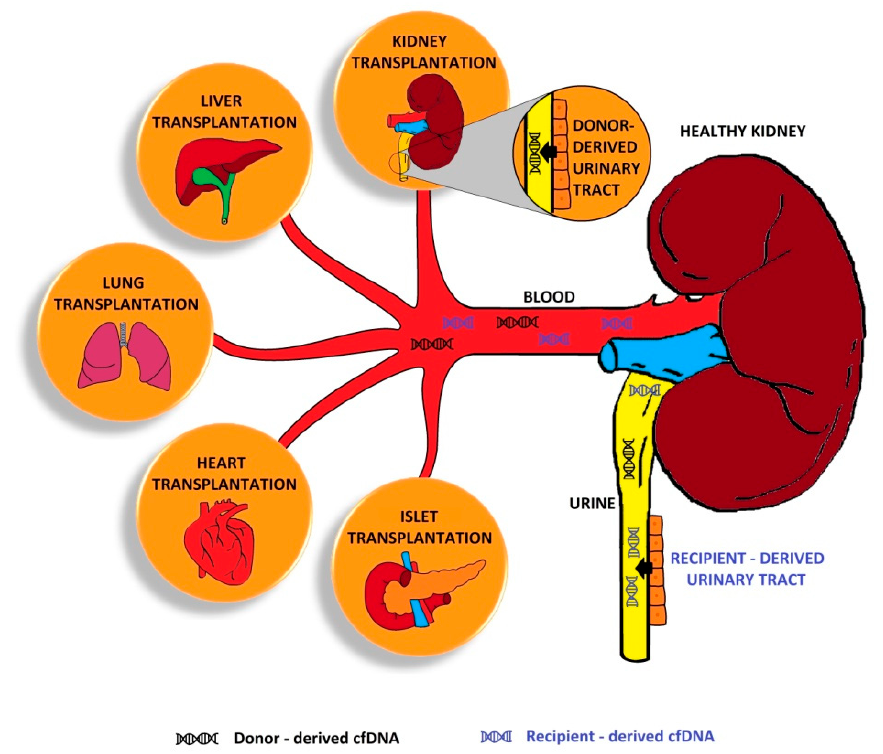
Figure 1. Distribution of cell-free DNA (cfDNA). Kidney transplantation (KTx) is captured here to highlight its dual function—as a kidney after other transplants and as a transplanted kidney. dd-cell-free DNA in a kidney transplant is secreted by donor-derived urinary tract and secreted into the blood.